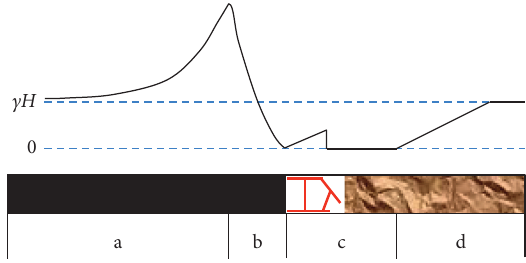
Figure 4: Abutment pressure distribution in advancing direction of working